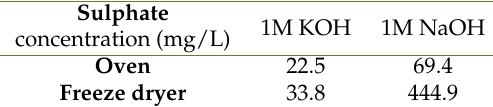
Table 4. Sulphate concentration of carrageenan